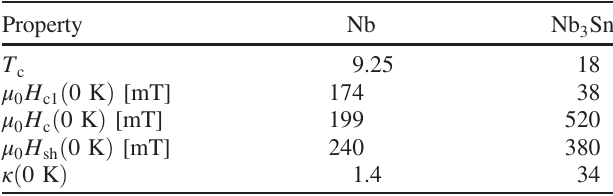
TABLE II. Material parameters of Nb and Nb 3 Sn.